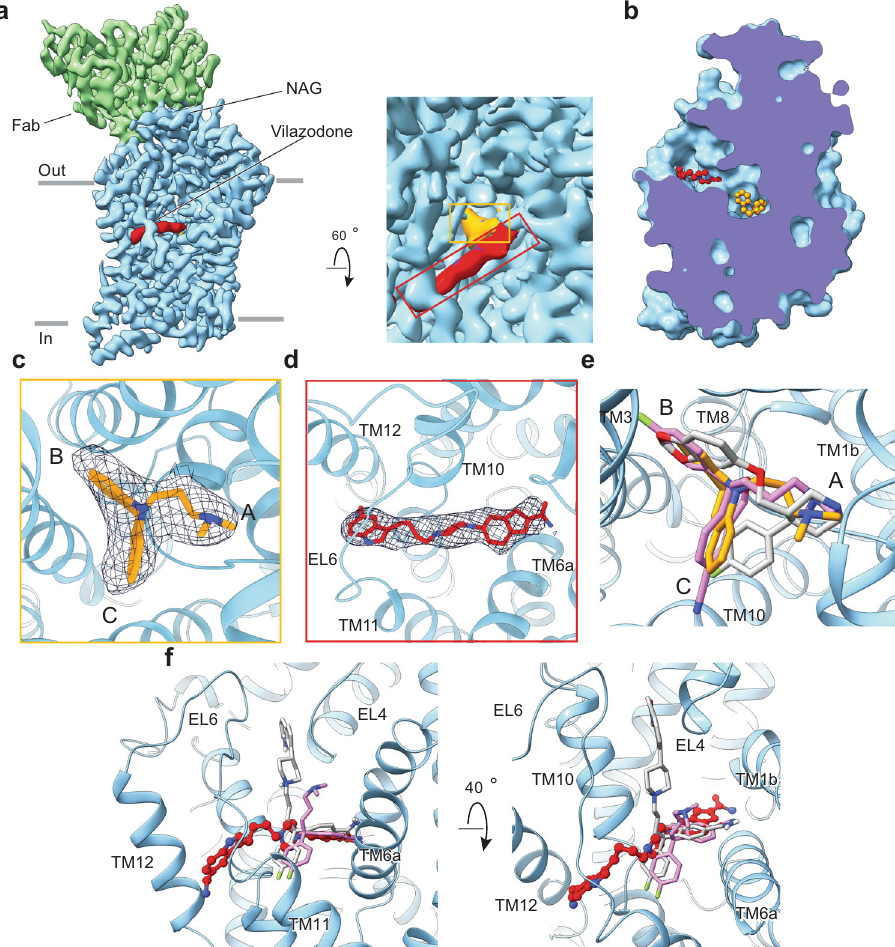
Fig. 3 Cryo-EM structure of SERT:IMI:VLZ complex. a The overall reconstruction of the SERT:15B8-Fab:IMI:VLZ complex at 3.65 Å (PDB: 7LWD). Right panel shows the zoomed allosteric and central sites. SERT is colored in light blue and the 15B8 Fab is shown in green. IMI and VLZ densities are shown in yellow and red, respectively. b Surface representation of the outward-open structure of SERT, viewed parallel to the membrane. The open extracellular pathway and the closed intracellular pathway are displayed. IMI and VLZ are shown as ball sticks. c Zoomed view of the IMI (yellow) binding site. IMI is shown fi t into a density feature at the S1 site with subsite A, B, and C and the involved SERT backbone structures (light blue) annotated. Parts of SERT have been removed for clarity. d VLZ (red) is shown fi t into a density feature at the allosteric site with the central SERT backbone structures annotated. Parts of SERT have been removed for clarity. e Comparison of the IMI (yellow) binding pose with the binding poses for S-CIT (light magenta, PDB code:5I73) and paroxetine (gray, PDB code:5I6X) within the S1 site. The main chain position of SERT from the IMI:VLZ complex is shown in light blue. f Comparison of VLZ (red) with S-CIT (light magenta, PDB code:5I73) and Lu AF60097 (gray). The main chain position of SERT from the IMI:VLZ complex is shown in light